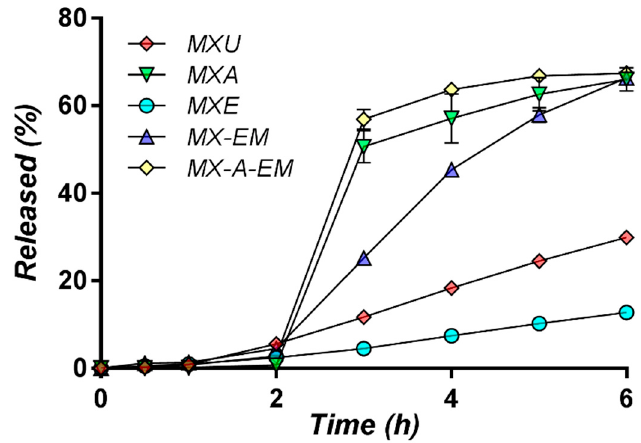
Figure 12. Comparative in vitro release profiles of the experimental meloxicam multi-particulate drug delivery systems.